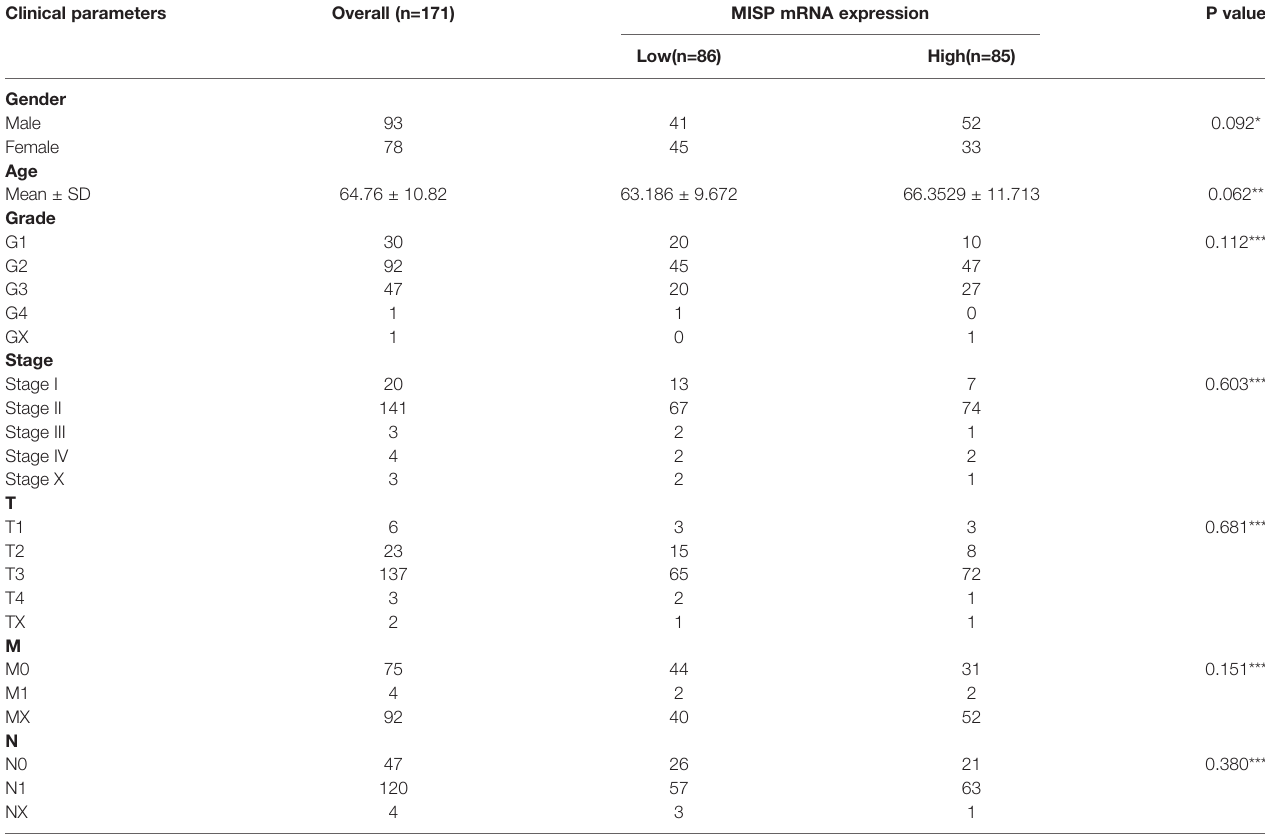
TABLE 1 | Baseline characteristics of PDAC patients strati fi ed by MISP expression. Clinical parameters